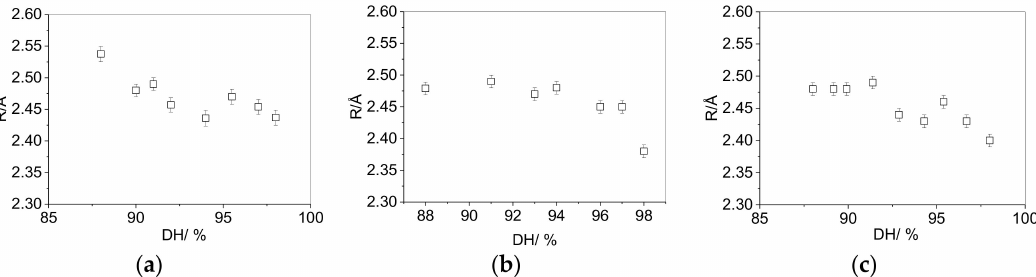
Figure 8. Effect of degree of hydrolysis on the cavity radius in non-plasticized, vacuum-dried PVA resins of different molecular weights: ( a ) PVA-23-(DH), ( b ) PVA-50-(DH), ( c )